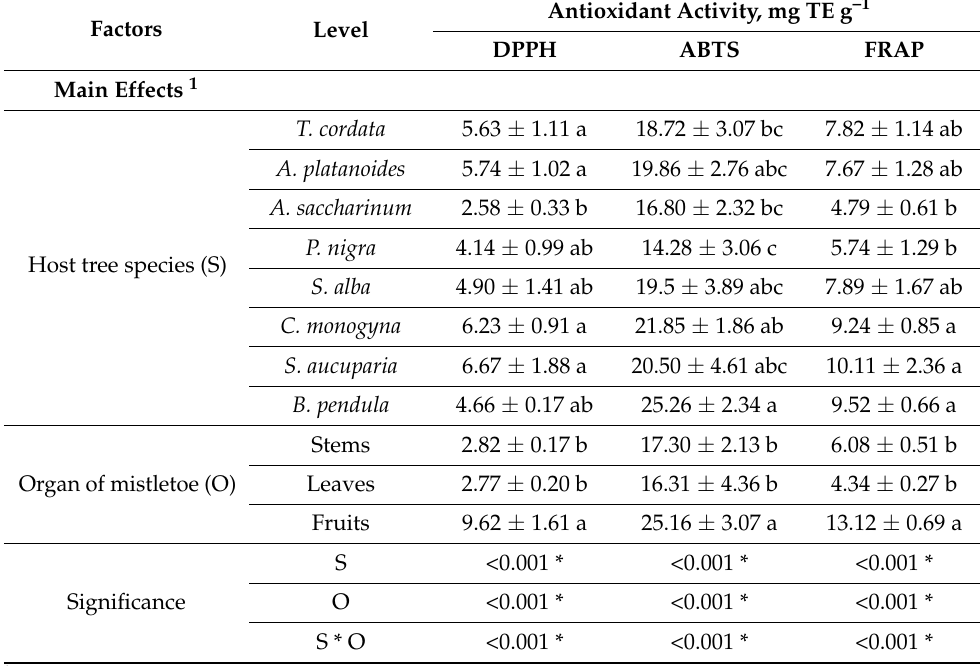
Table 5. Antioxidant activity of extracts from the leaves, stems, and fruits of mistletoe harvested from different host tree species.